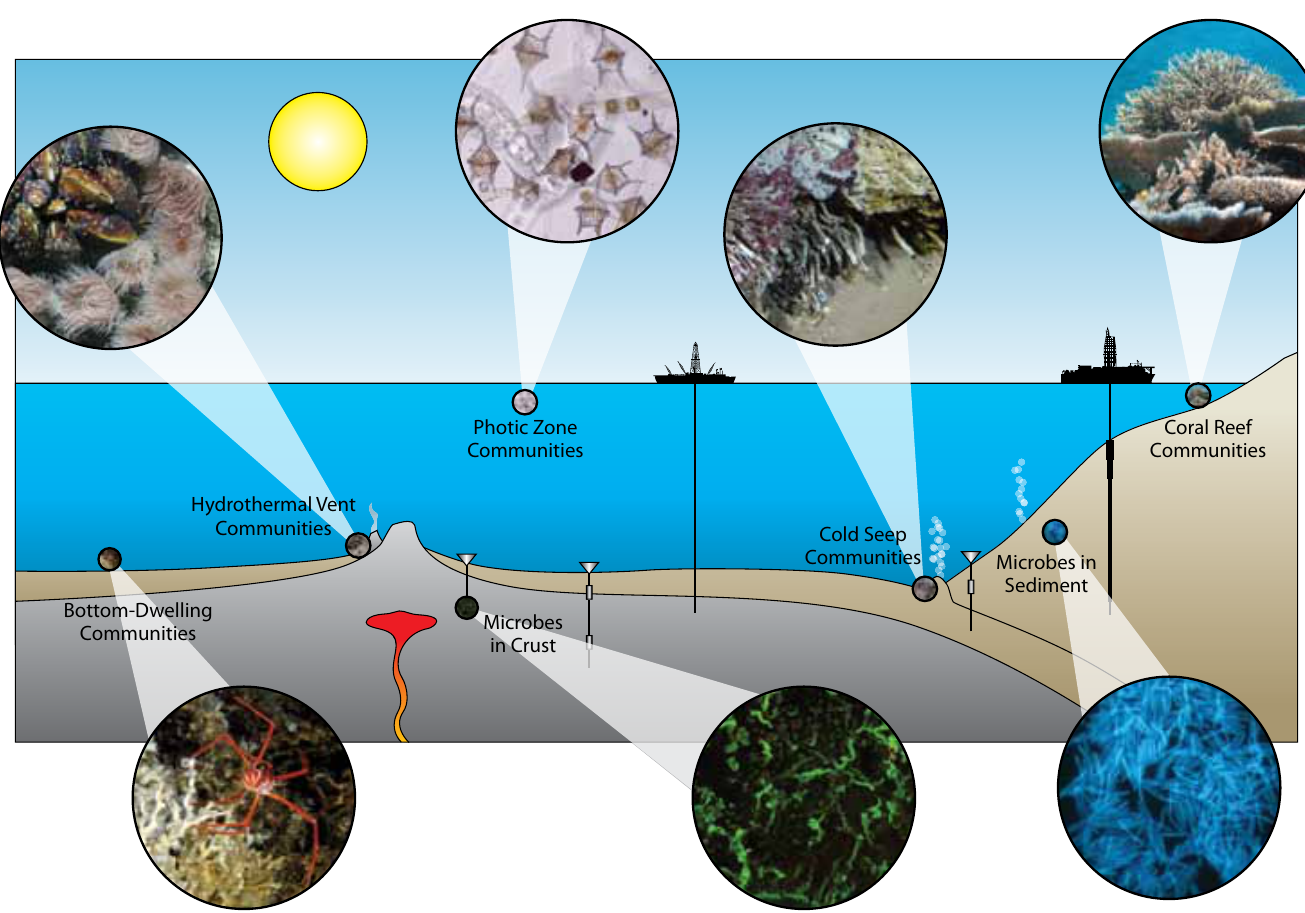
figure 3.1 The presence and size of the deep biosphere may affect the earth system in ways we have yet to appreciate. microbes in extreme environments such as hydrother- mal vents, mud volcanoes, and deep-sea hydrocarbon seeps are capable of producing organic carbon without the sun’s energy. These chemosynthetic microbes also play an important, but yet quantitatively uncertain, role in the global carbon and other cycles. photos from: Bottom dwelling: ross (2007; figure 3); hydrothermal vents: devey et al. (2007, figure 2); microbes in crust: orcutt et al. (2010); photic Zone: m. montresor, sZn/alfred Wegener institute; cold seep communities: vanreusel et al. (2009, figure 6a); microbes in sediment: figure 3.2B; coral reef: coral disease Working group (2007; figure 2).